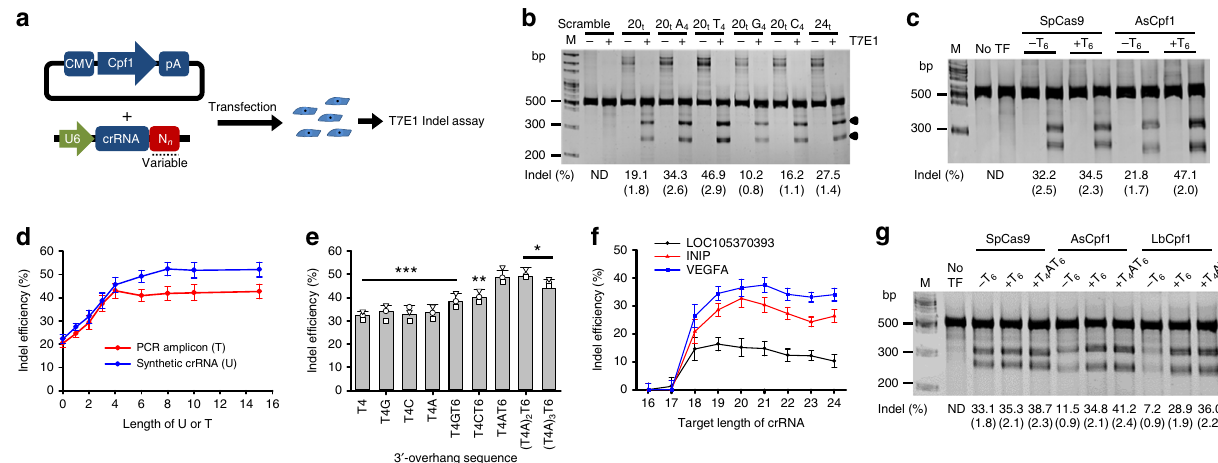
Fig. 2 Optimized con fi guration of crRNA for highly ef fi cient genome editing in vivo. a Scheme of the in vivo assay to determine the most ef fi cient con fi guration of the crRNA. Cpf1-encoding plasmids were co-transfected with crRNA-encoding PCR amplicons into HEK-293T cells, and the Cpf1 activity was assessed by T7E1 indel assays. b Improved indel ef fi ciency of AsCpf1 in vivo by the U-rich 3 ′ -overhang following a 20-nt target-complementary sequence in transcribed crRNAs. This gel image is a representative result of three repeated experiments. Indel values are mean±standard deviation. c Improved indel ef fi ciency by the 3 ′ -end U-rich guide RNA as a unique feature of Cpf1. 3 ′ -Proximal addition of uridinylates did not change the indel ef fi ciency of SpCas9 in vivo. This gel image is representative of three repeated experiments. Indel values are the mean±standard deviation. d Improved indel ef fi ciency of AsCpf1 in vivo by increased uridinylate lengths. The AsCpf1 activity was improved by the increased lengths of 3 ′ -end uridinylates up to 8 –